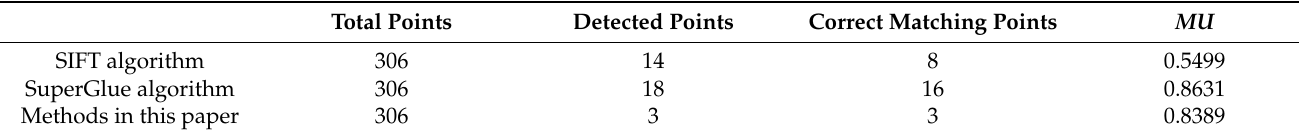
Table 4. Comparison of feature point matching results of different algorithms.